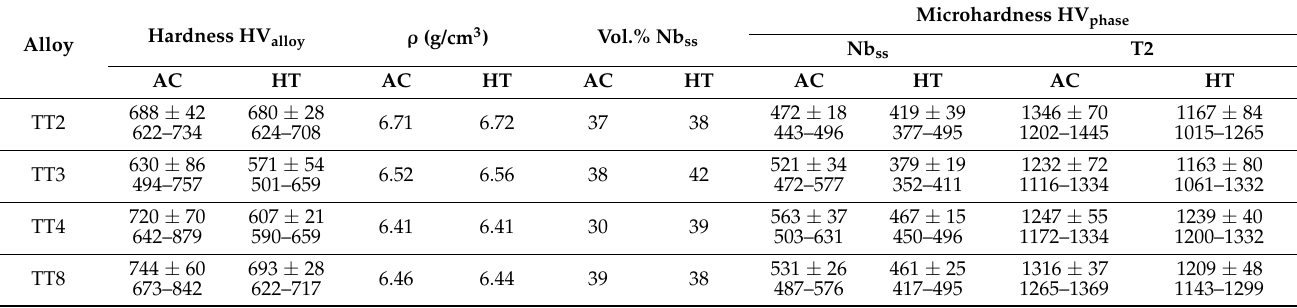
Table 2. Density of alloys, vol.% Nb ss , hardness * of alloys, microhardness * of Nb ss and T2 silicide. Alloy